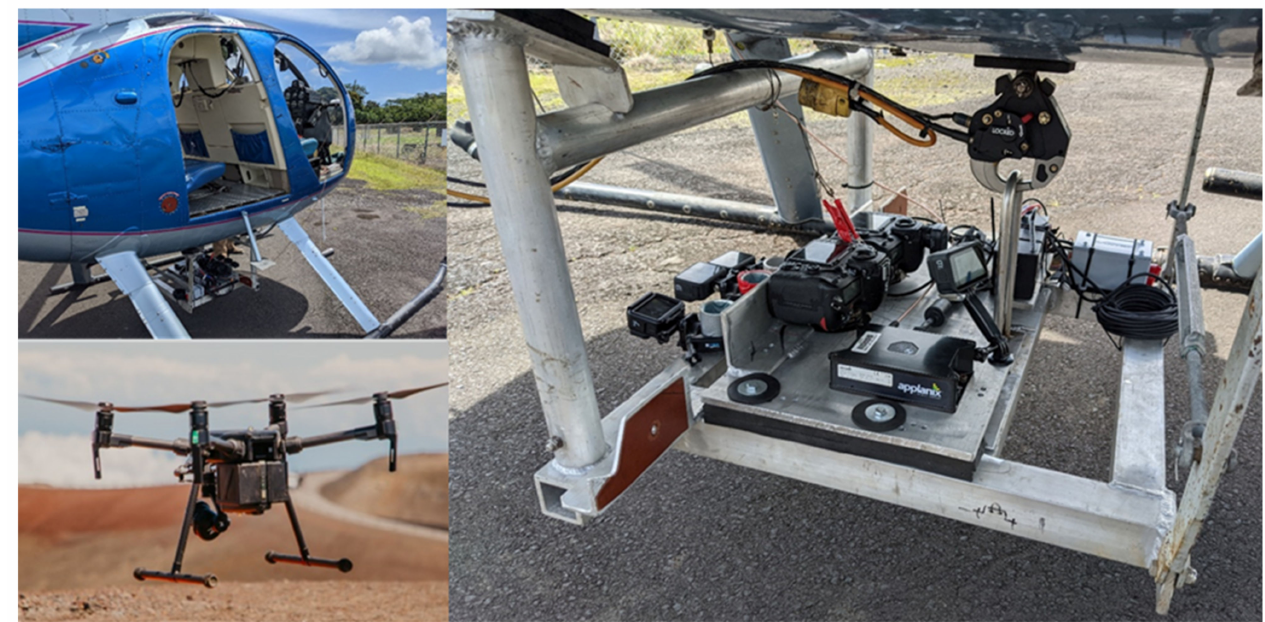
Figure 3. (Top left and right panel) Custom imaging payload developed for Hughes 500 helicopter mapping operations in Hawai‘i. (Bottom left) sUAS platform used for mapping